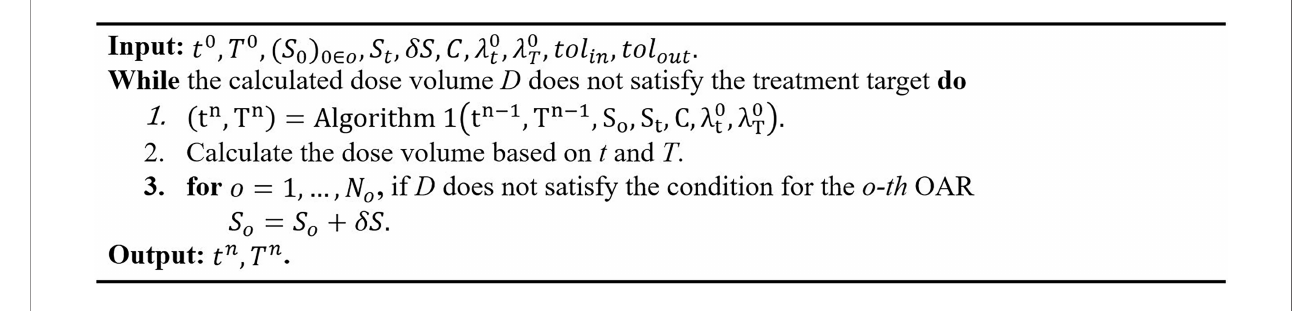
FIGURE 4 | Automatic search algorithm.